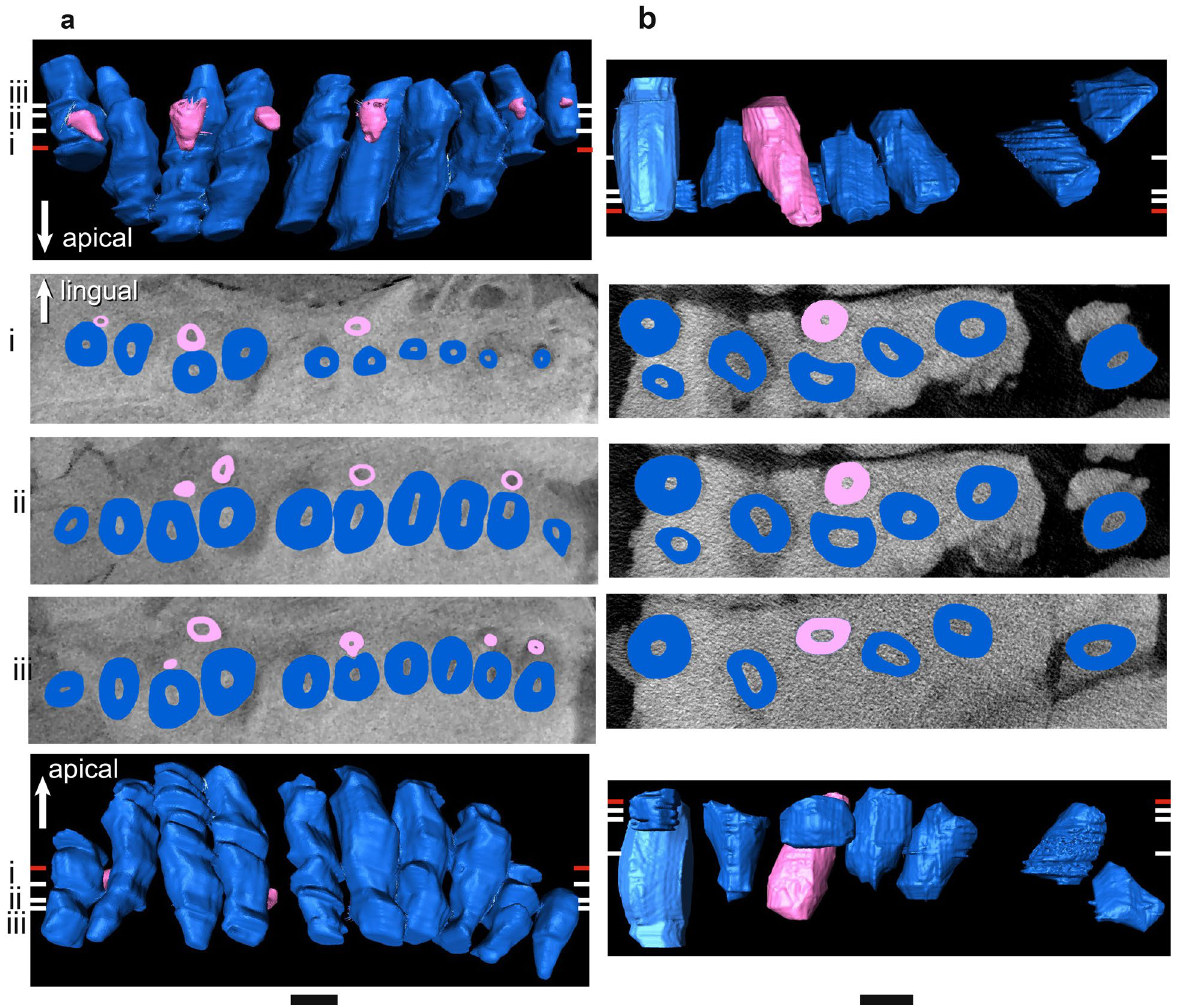
Figure 10. µCT scans of Endothiodon maxillary ‘postcanine’ teeth in horizontal section (middle three rows), lingual view (top row), and labial view (bottom row). ( a ) Endothiodon tolani NHCC LB684 (mirrored), ( b ) Endothiodon bathystoma NMT RB23 with multiple rows. Horizontal sections were taken at numbered positions indicated on the labial and lingual views. The level of the gumline is indicated by a red tick mark on labial and lingual views. Replacement teeth are highlighted in light pink and functional teeth in medium blue. Anterior is to the left. Scale bars 5